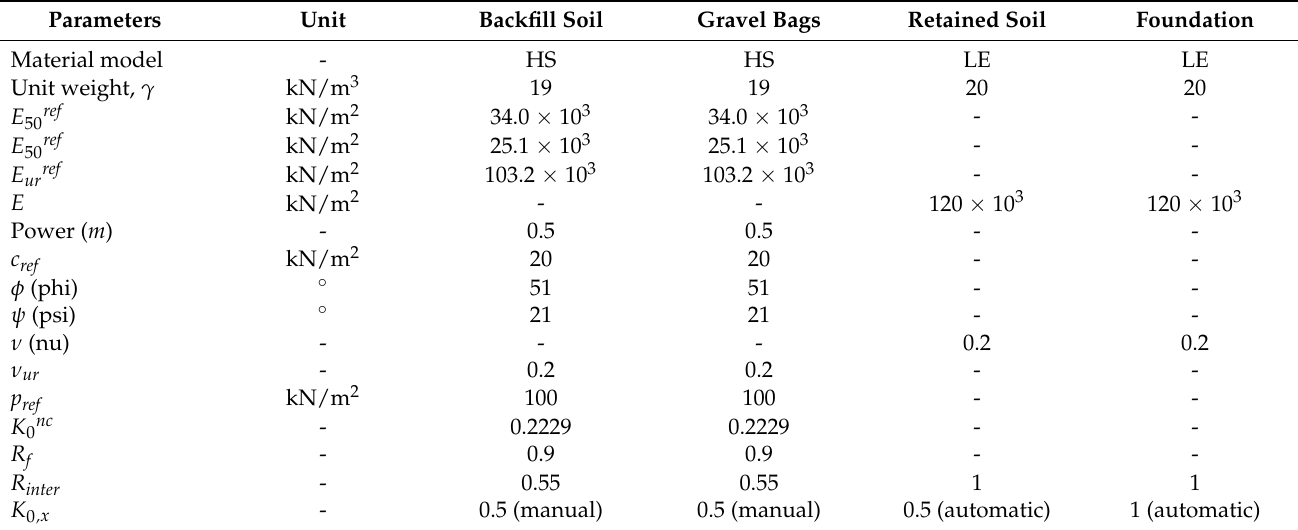
Table 1. Model soil material input